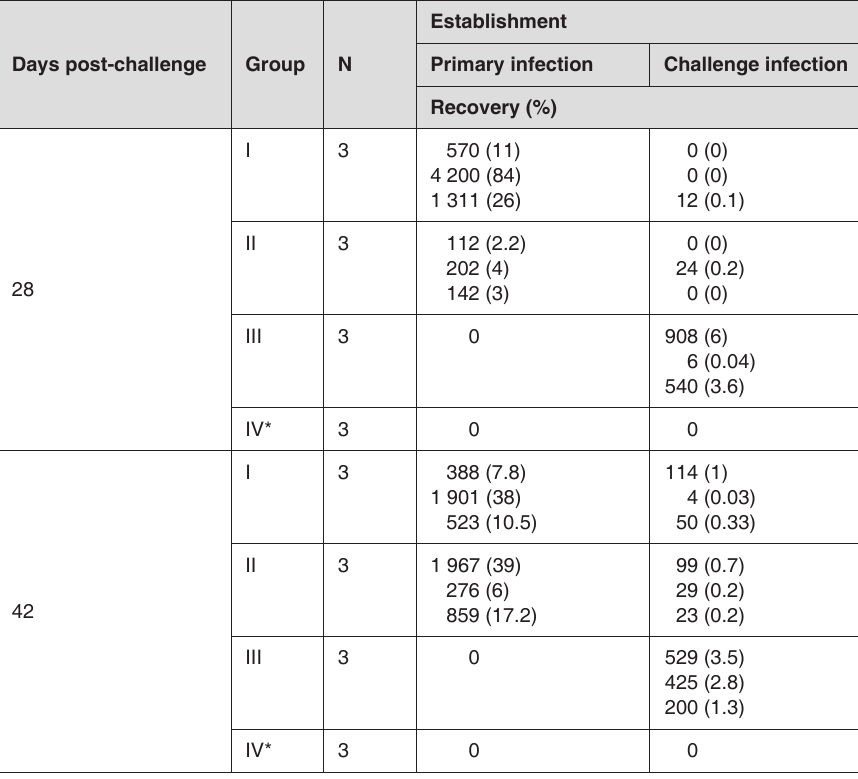
TABLE 2 Establishment patterns of Calicophoron microbothrium in the different groups of cattle im- munized and challenged with C. microbothrium